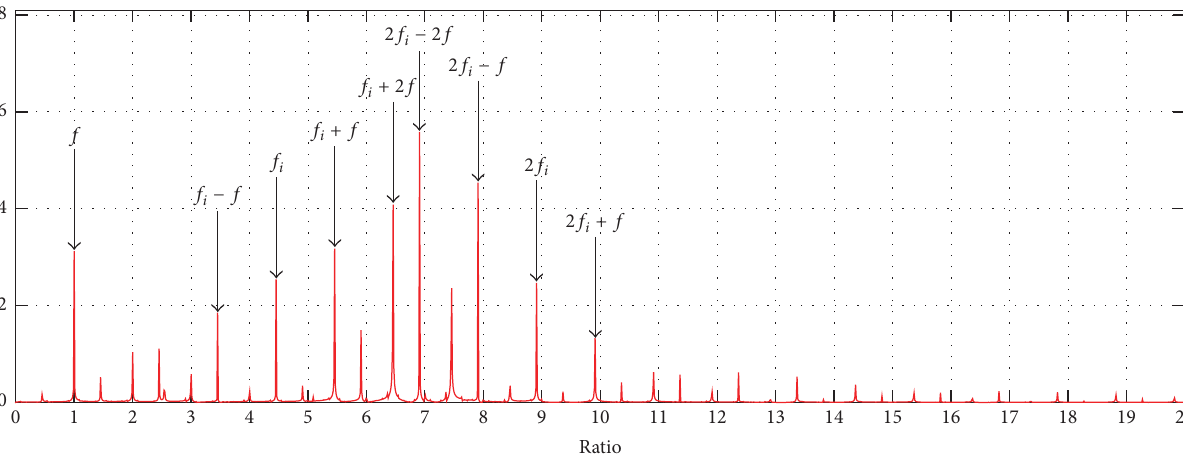
Figure 13: The spectral diagrams of the faulted system with SFD mounted on the normal bearing at 𝜔 = 150 rad/s and width = 1𝑒 − 3 m.